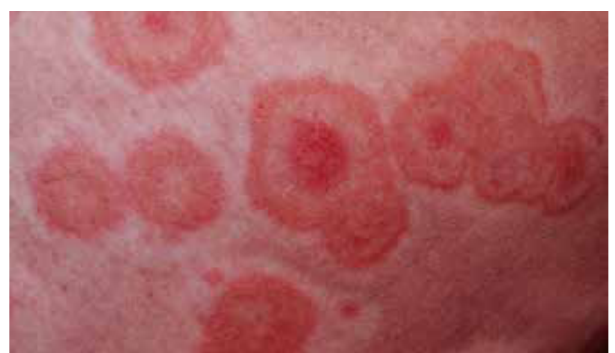
Figure 1: MCQ skin